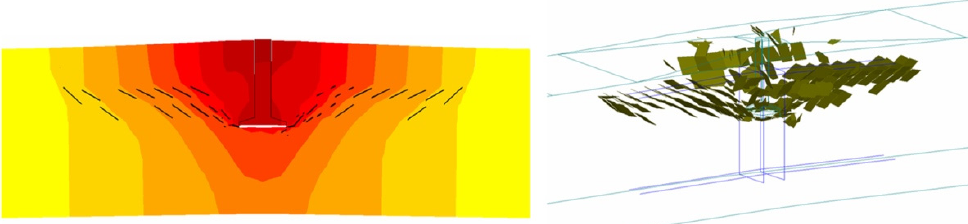
Figure 17. Comparison of results of the experimental test with numerical simulation—specimen with supplementary reinforcement.